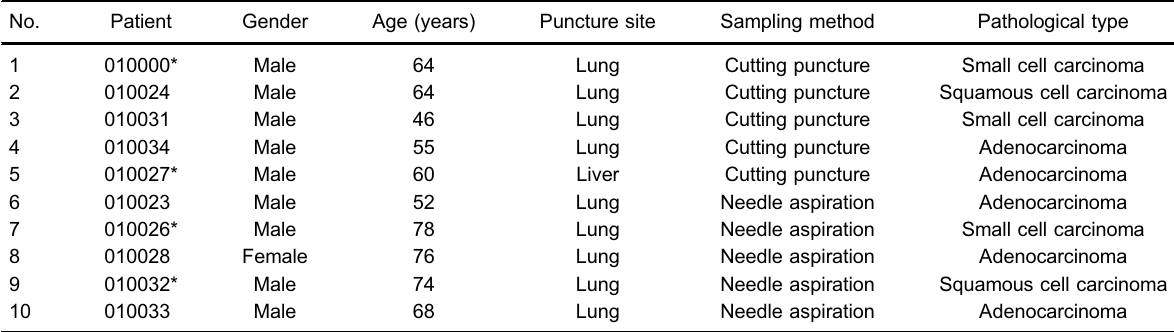
Table 1. Biopsy sites, sampling methods and pathological types for the 10 patients with cancer.